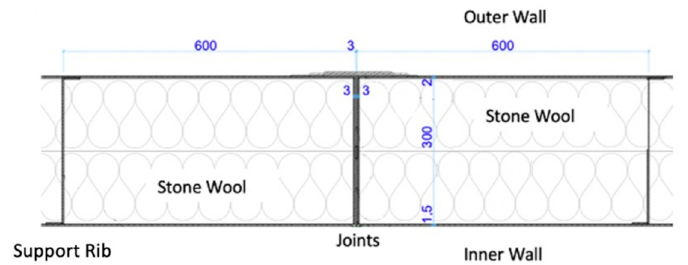
Figure 2. Horizontal fiberglass panels used in the roof of the fiberglass